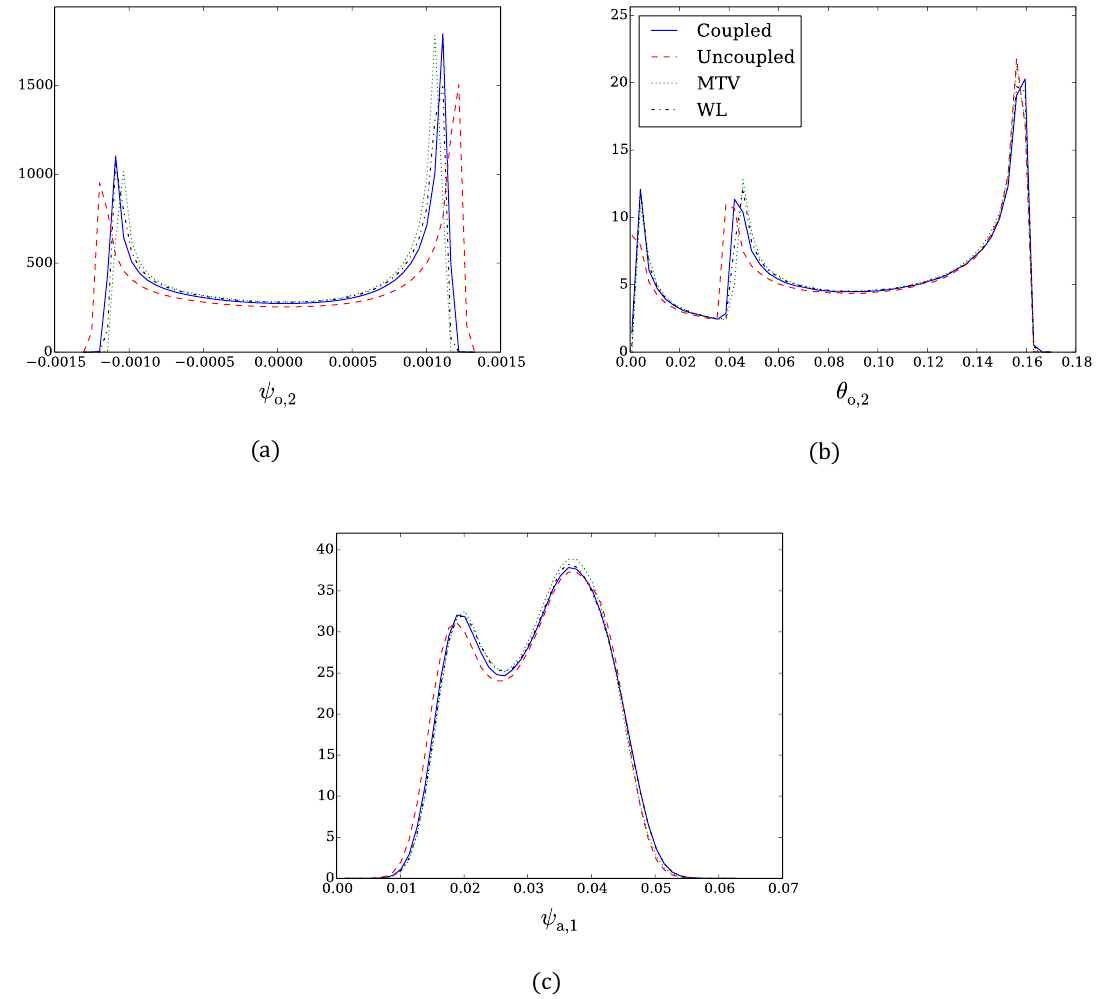
Figure 8. Probability density functions (PDFs) of the dominant variables of the system dynamics as in Fig. 2, but for the wavenumber 2 baroclinic parameterization and with the parameter set DV2017. Table 4. Component averaged Kullback–Leibler divergence with respect to the distributions of the full coupled system, in the case of the wavenumber 2 and F 4 modes atmospheric parameterization. Barotropic atm. Baroclinic atm. Barotropic oc. Temperature